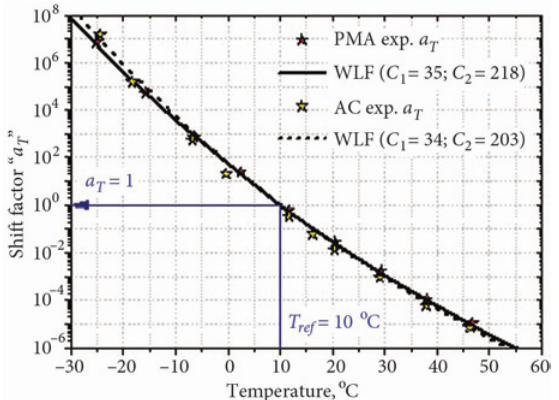
fig. 3. Experimental and calculated shift factors (using WLF law) considered for construction of E * and ν * master curves for the two bituminous materials (PMA and AC) plotted at T ref = 10